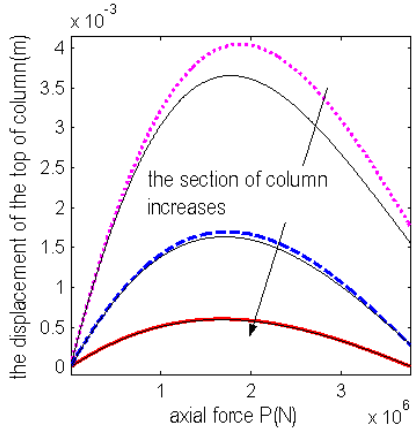
Fig.4 Lateral force versus displacement The relation between the of shown in Fig.5.